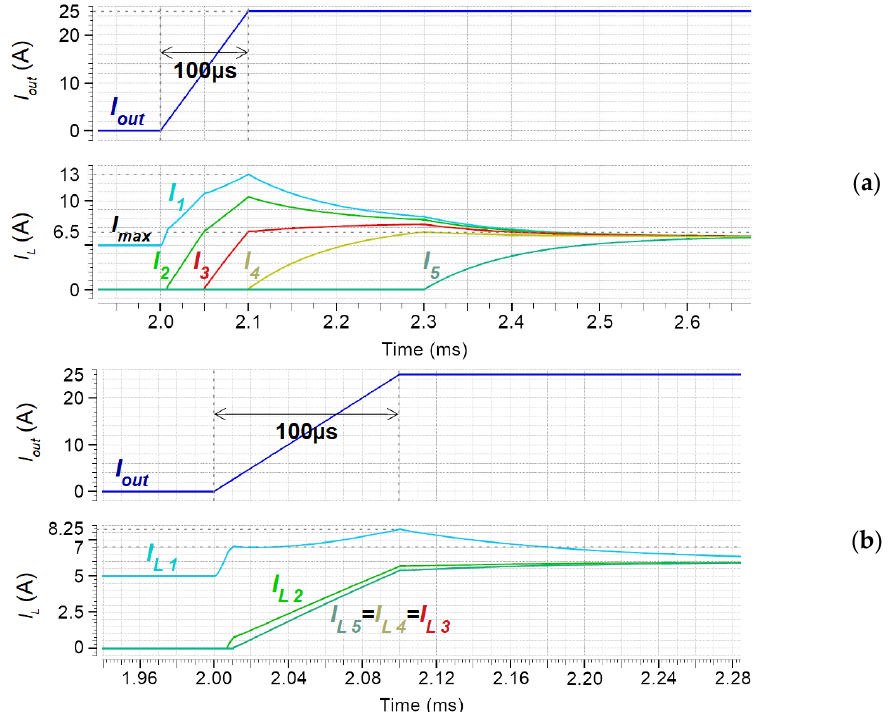
Figure 9. Simulation of the converter response for a current inrush transient: ( a ) with I nrush threshold deactivated; ( b ) with I nrush threshold activated.